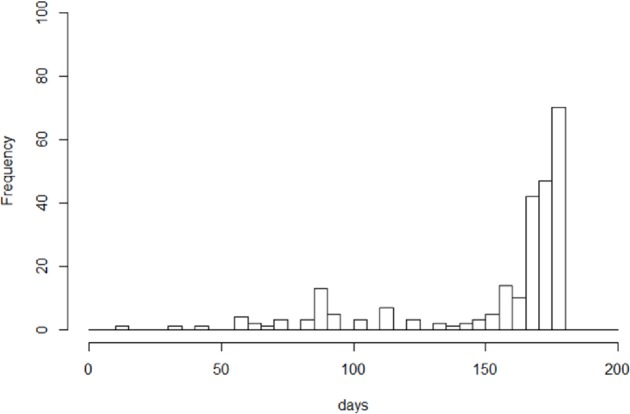
Treatment duration (in days) of infants and pre-school children who did not complete treatment, 2012–2014.The figure shows the treatment duration, in days, of infants and pre-school children who did not complete the treatment according to the study definition but were nevertheless recorded as “treatment completion”.